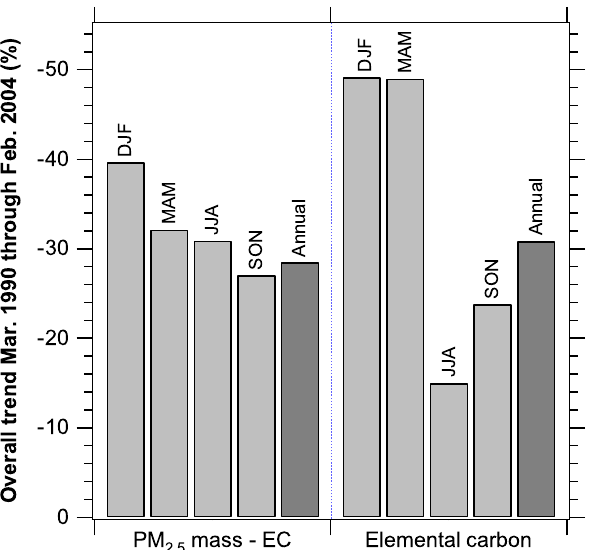
Fig. 5. Seasonal average national trends for the 14-year period